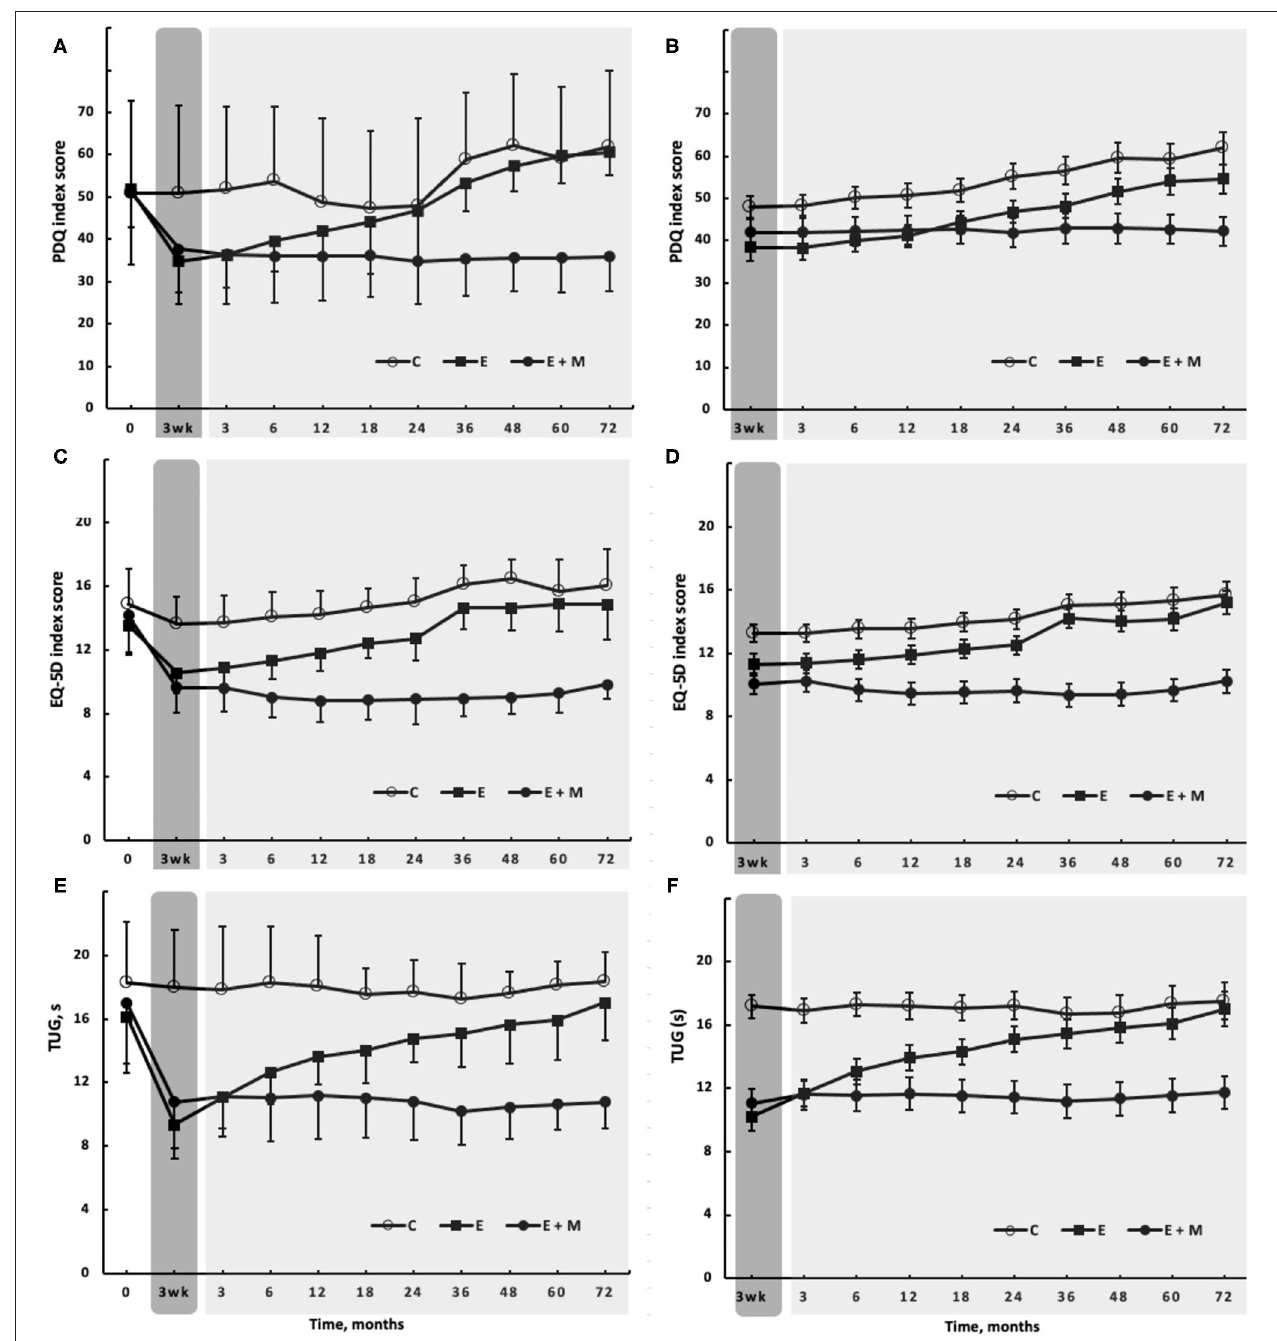
FIGURE 3 | The effects of 3-week-long, high-intensity Exergaming agility exercise program (dark gray rectangle) with (filled circles, E + M, n = 19) or without (filled squares, E, n = 22) 72-month-long Exergaming agility exercise Maintenance program, on selected secondary outcomes, including: Parkinson’s Disease Questionnaire- 39 [PDQ, (A) ]; EuroQol five dimensions questionnaire on quality of life [EQ-5D, (C) ], and Timed-Up-and-Go test [TUG, (E) ]. (A,C,D) Show the observed scores, such as baseline. (B,D,F) Show the longitudinal linear mixed effects modeling of the corresponding outcomes fitted with maximum likelihood estimation, adjusted for the baseline and